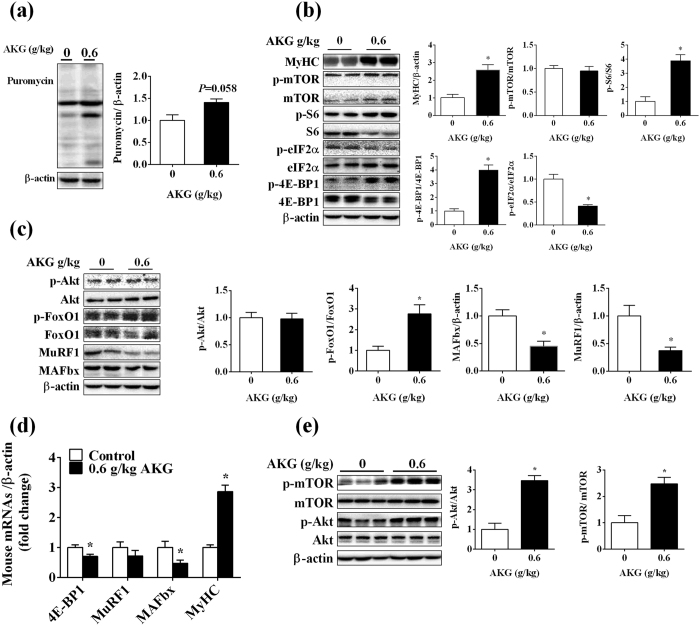
AKG regulated the protein synthesis of the skeletal muscle of mice.AKG (0.6 g/kg) and puromycin were co-injected for 3 h. Protein turnover associate protein expression was detected by Western blot. (a) The expression of puramycin was analyzed by Western blot. (b) The expression of MyHC and the phosphorylation levels of mTOR, S6, 4E-BP1, eIF4E, eIF2a in the gastrocnemius of mice. (c) The expression of Akt, MAFbx, and MuRF1. (d) The mRNA expression levels of protein turnover related genes were measured by qPCR. (e) The phosphorylation levels of Akt and mTOR 1 h after AKG injection detected by Western blot. Data are presented as mean ± SEM. *means P < 0.05 compared with the control. β-actin served as a housekeeping gene control.